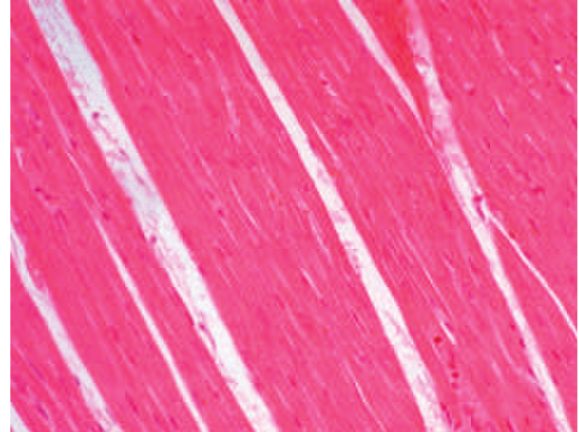
FIG. 6 Normal Dorper heart